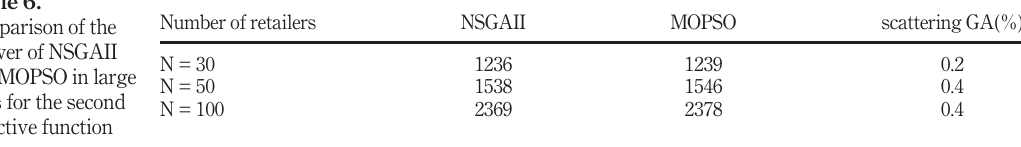
Table 5. Comparison of the answer of NSGAII and MOPSO in large sizes for the fi